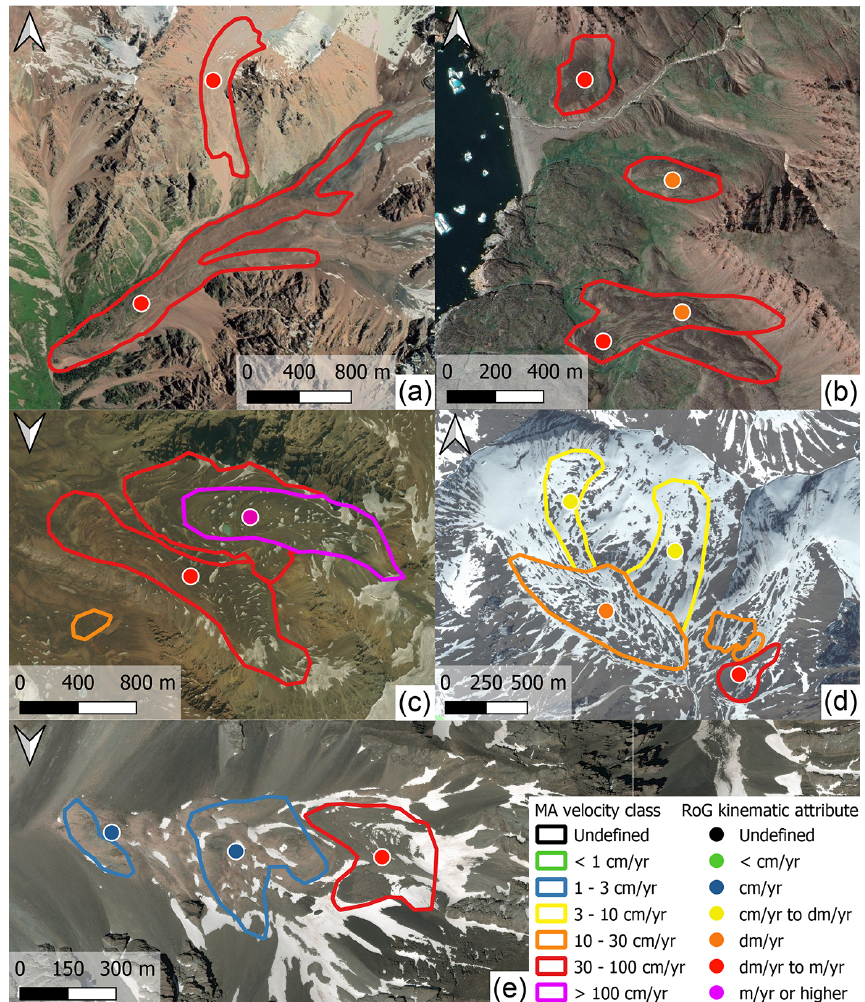
Figure 6. Examples of MAs and RoG kinematic attributes produced for the northern Tien Shan ( a , location: 43 ◦ 06 (cid:48) 00 (cid:48)(cid:48) N, 77 ◦ 12 (cid:48) 20 (cid:48)(cid:48) E, 3400m), Disko Island ( b , location: 69 ◦ 15 (cid:48) 50 (cid:48)(cid:48) N, 53 ◦ 37 (cid:48) 20 (cid:48)(cid:48) W, 100m), the Central Andes ( c , location: 33 ◦ 00 (cid:48) 10 (cid:48)(cid:48) S, 69 ◦ 35 (cid:48) 00 (cid:48)(cid:48) W, 4400m), Brooks Range ( d , location: 68 ◦ 06 (cid:48) 25 (cid:48)(cid:48) N, 150 ◦ 00 (cid:48) 18 (cid:48)(cid:48) W, 1700m) and the central Southern Alps ( e , location: 43 ◦ 35 (cid:48) 40 (cid:48)(cid:48) S, 170 ◦ 44 (cid:48) 00 (cid:48)(cid:48) E, 2000m). Orthoimages from © Google Earth